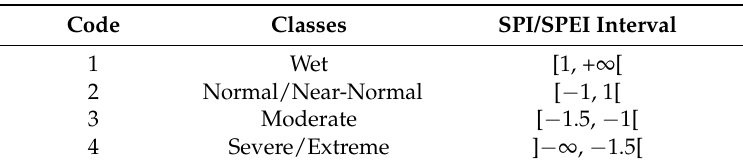
Drought and wetness classes of SPI/SPEI for modeling purposes (modified from Mckee et al.